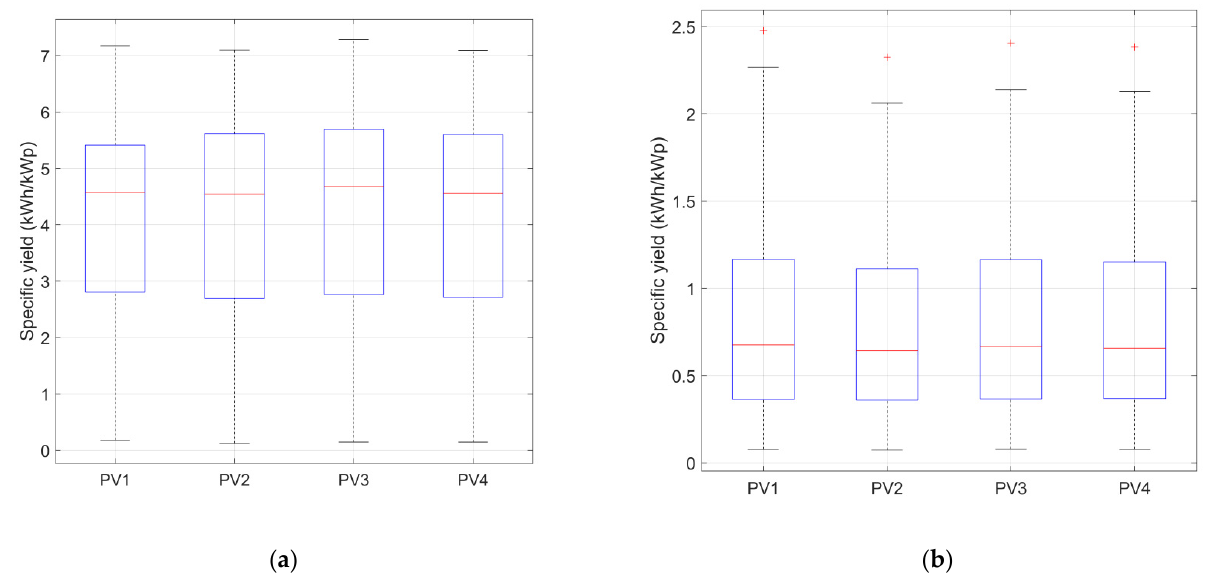
Figure 3. Daily specific yields of the PV1–PV4 systems in ( a ) April 2021 and ( b ) November 2020.